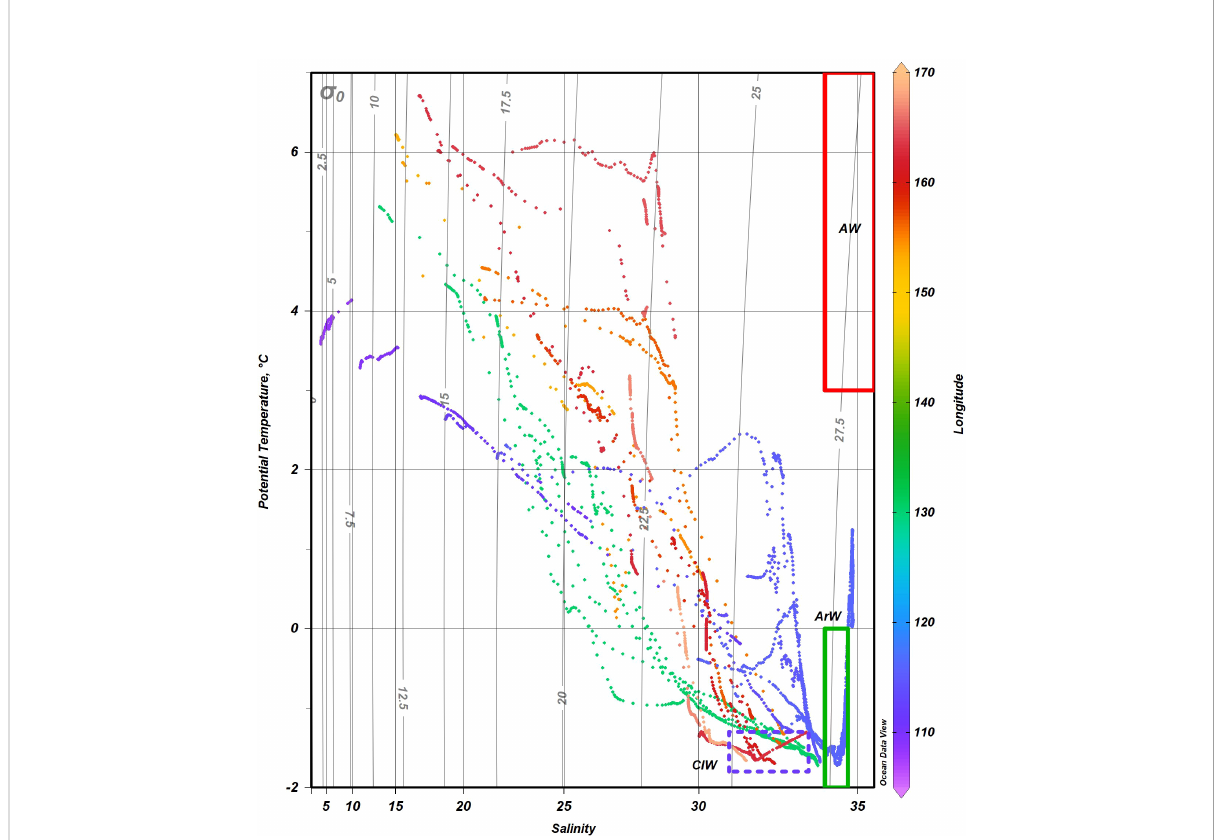
FIGURE 3 Potential temperature-salinity diagram over the shelf and slope regions of the Laptev and East Siberian seas. Blue dots correspond to Khatanga transect, green – Lena, orange – Indigirka, and red – Kolyma. Red and green rectangles correspond to Atlantic (AW) and Arctic (ArW) waters, respectively, in accordance with the water mass de fi nition given in (Oziel et al., 2016). Blue dotted rectangle shows cold intermediate waters (CIW) formed during winter